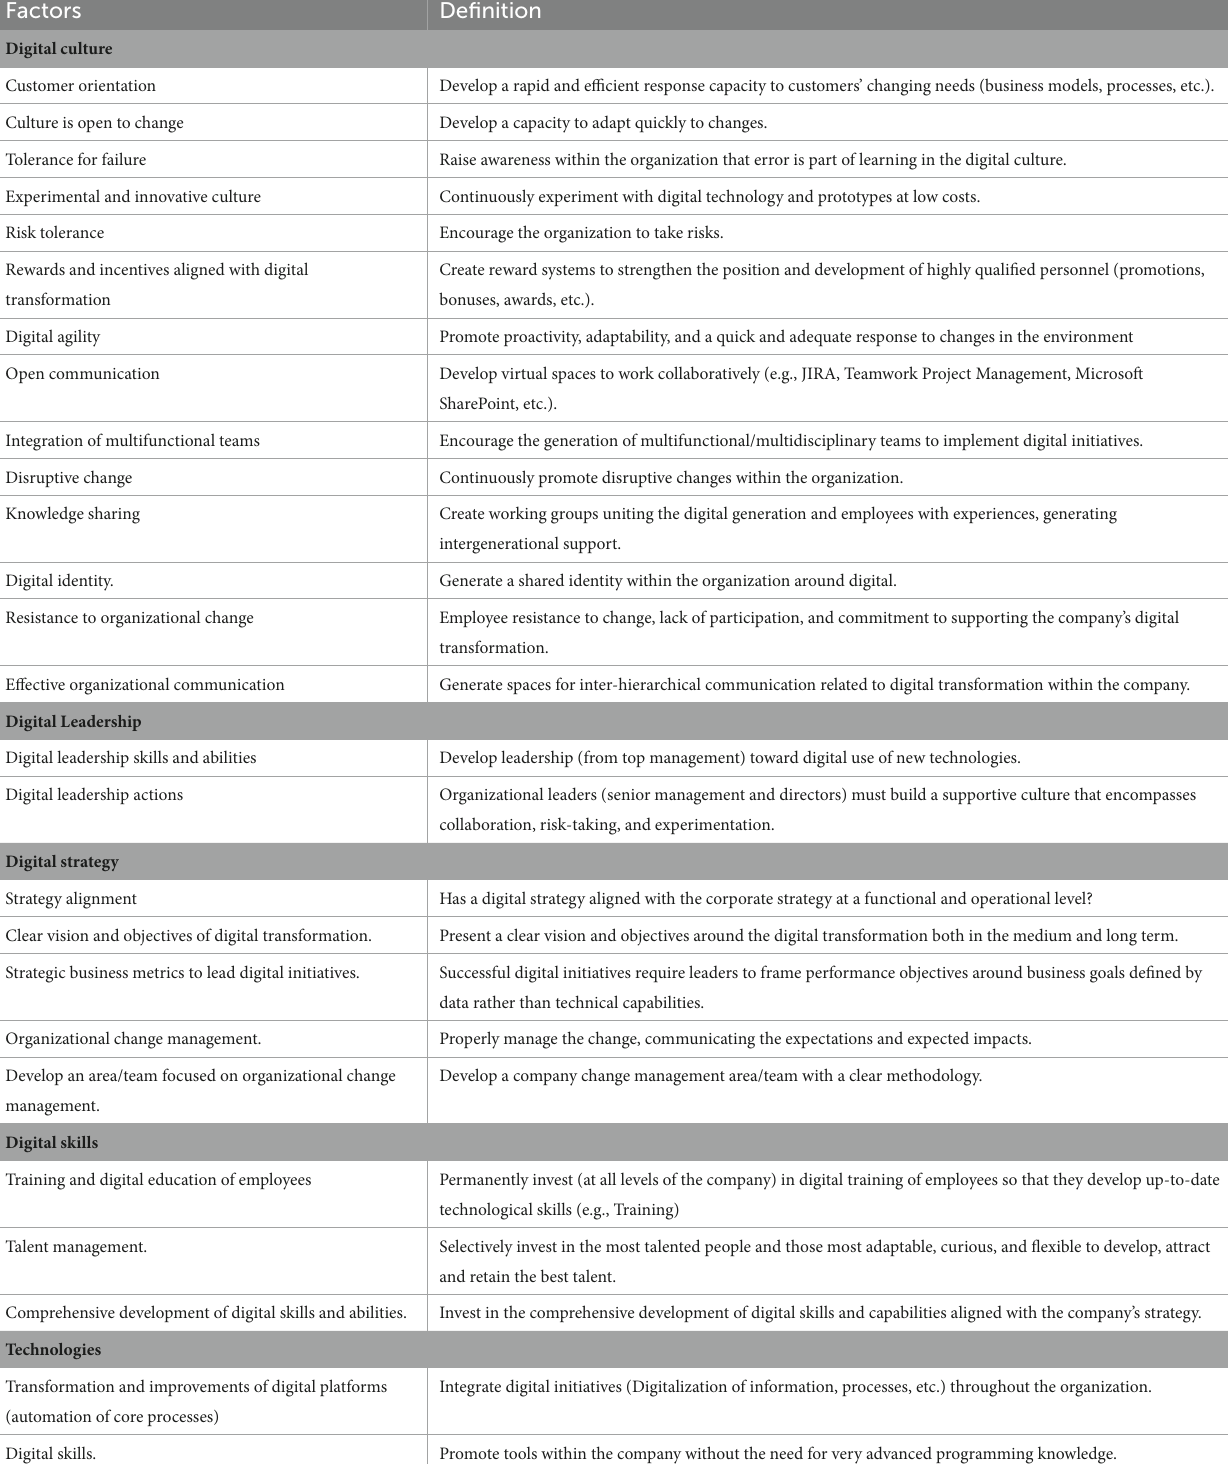
TABLE 1 Complete list of factors and definitions grouped into